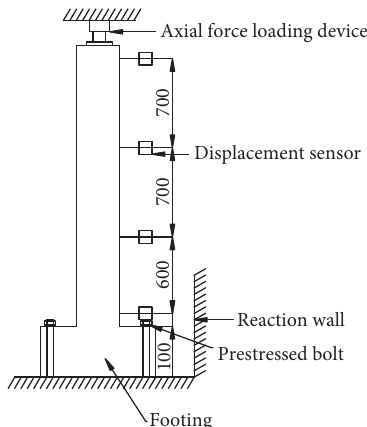
Figure 9: Displacement measurement points (unit: